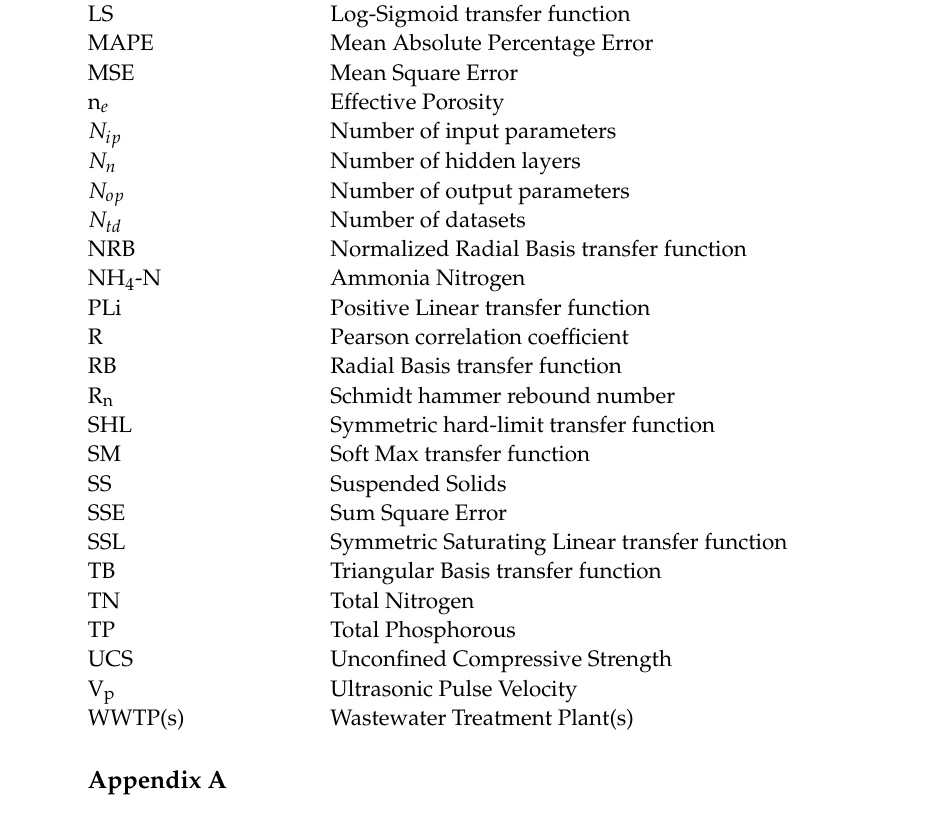
Table A1. Transfer functions.